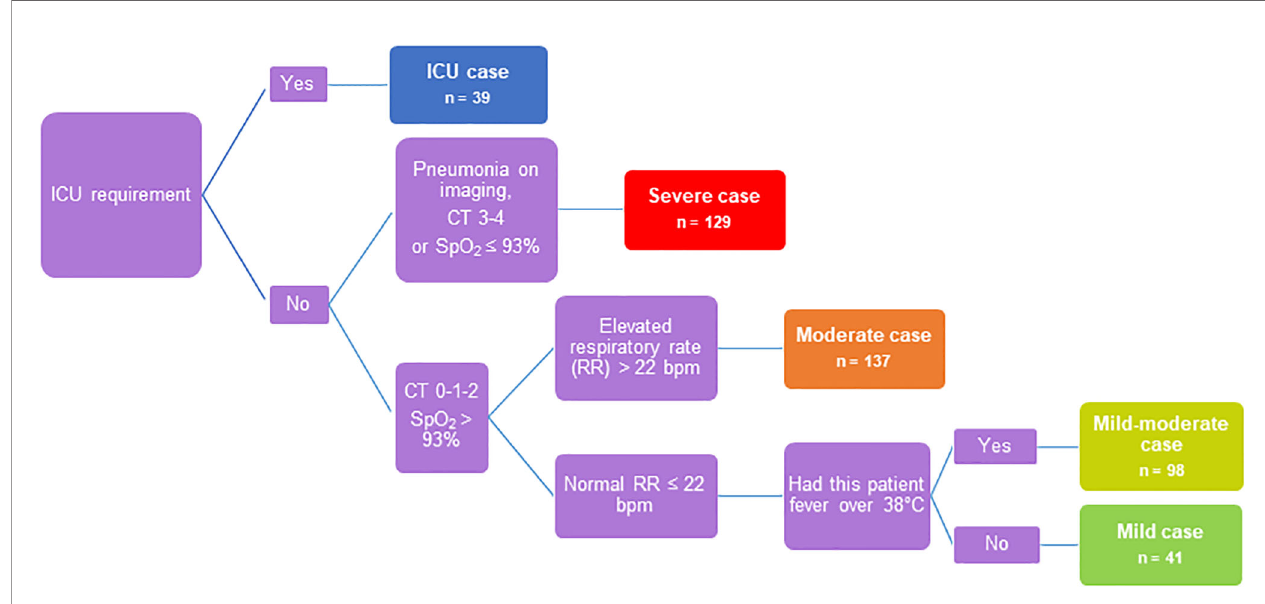
FIGURE 1 | Flow chart to determine disease